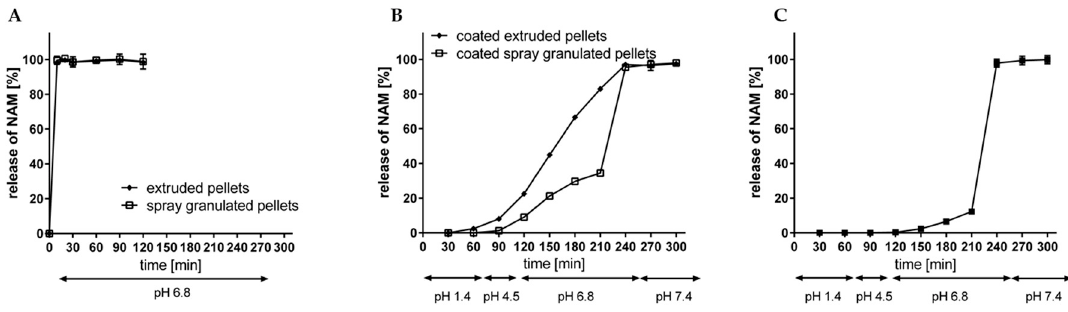
Figure 14. Release rate of NAM from ( A ) uncoated spray granulated and extruded NAM and ( B ) from triple shellac coated spray granulated and extruded NAM pellets with a coating thickness of 3.7/4.9/6.2 mg/cm 2 and 3.6/4.6/6.0 mg/cm 2 and ( C ) from triple shellac coated extruded NAM pellets with a coating thickness of 5.8/7.6/10.0 mg/cm 2 at simulated gastrointestinal conditions (mean ± SD; n = 2).